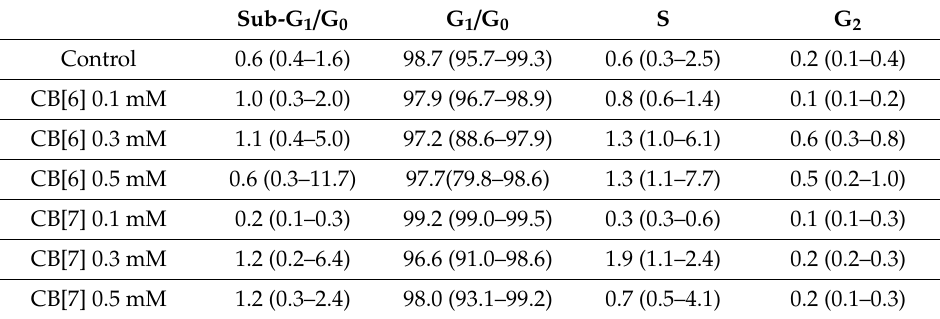
Table 2. Relative number of cells in different phases of the cell cycle during anti ‐ CD3 ‐ induced proliferative activity of PBMCs cultured for 72 h in the presence of different concentrations of CB[n]. Data are presented as the median with interquartile range.